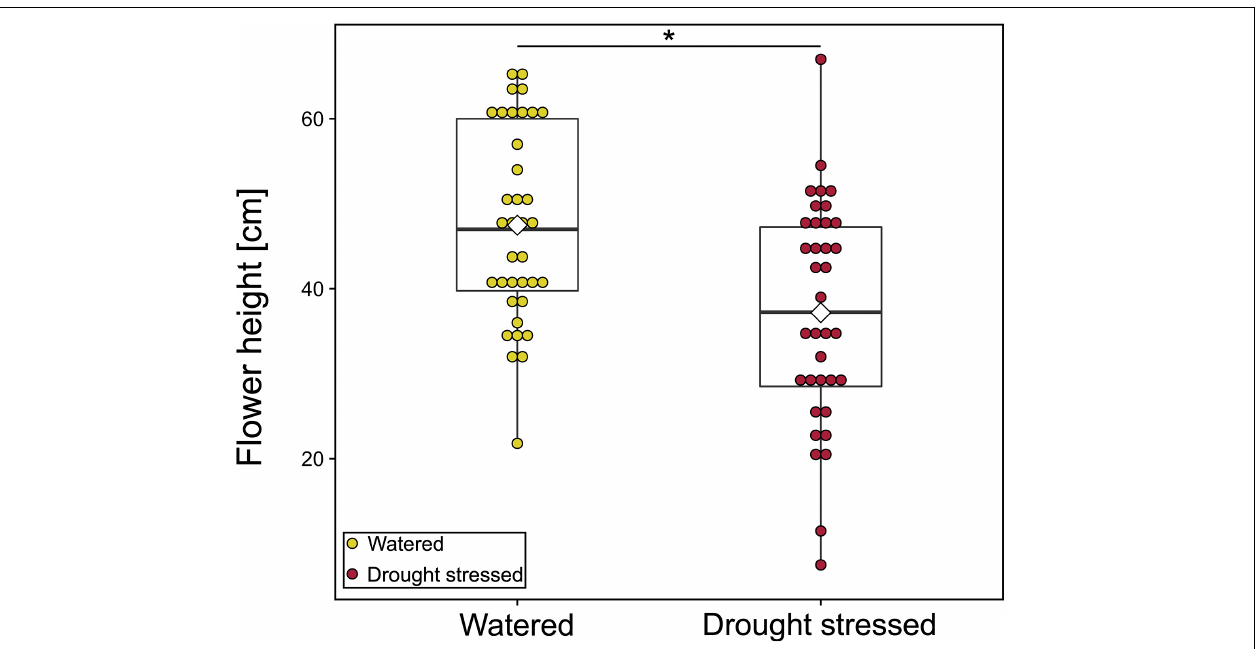
FIGURE 4 | Flower height [cm] of watered and drought-stressed plants. Each colored dot shows mean value of one plant for all observation days. Watered: N = 36 [mean (SD) 47.5 (11.5) cm]; drought stressed: N = 36 [mean (SD) 37.2 (13.1) cm]. Boxplots show median range, interquartile range, and minimum/maximum range. White diamonds show mean height. Means of each plant were compared using linear mixed-effect models. * p <